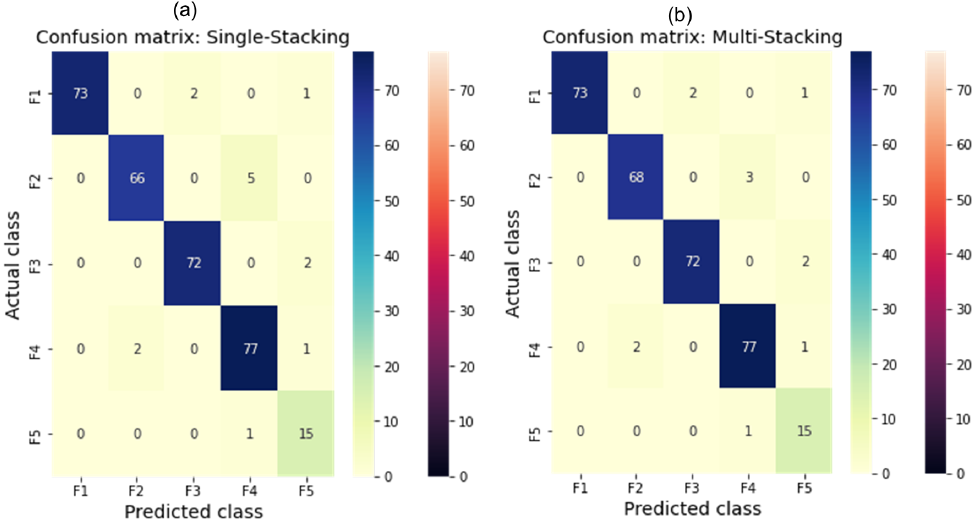
Figure 11. Confusion matrices: ( a ) single-stacking classifier and ( b ) multi-stacking